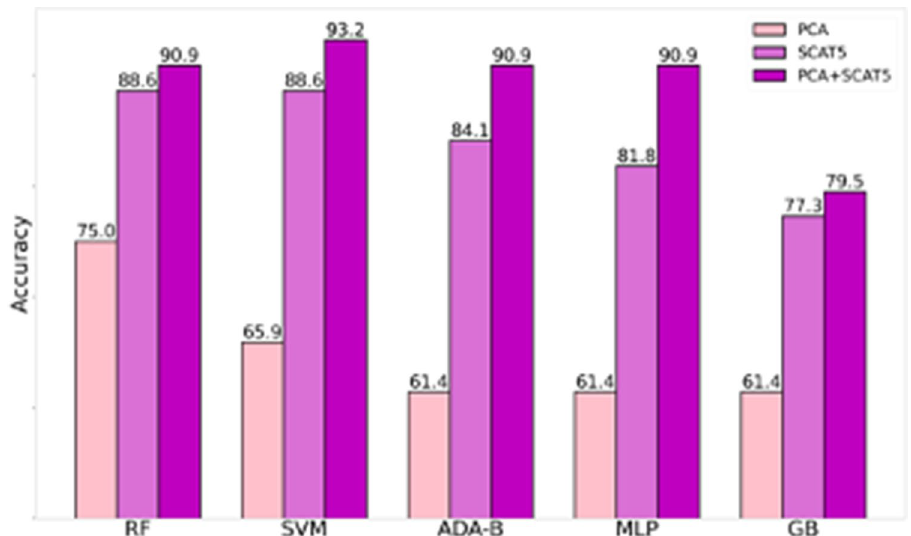
Figure 7. The results of 5 different algorithms (RF- Random Forest, SVM—Support Vector Machine, ADA-B— Adaptive Boosting , MLP- Multilayer Perceptron, GB-Gradient Boosted) and combinations of features. Highest accuracy in all algorithms is achieved using both the PCA and SCAT5 features, but highest accuracy overall (95.5%) when computed with an SVM